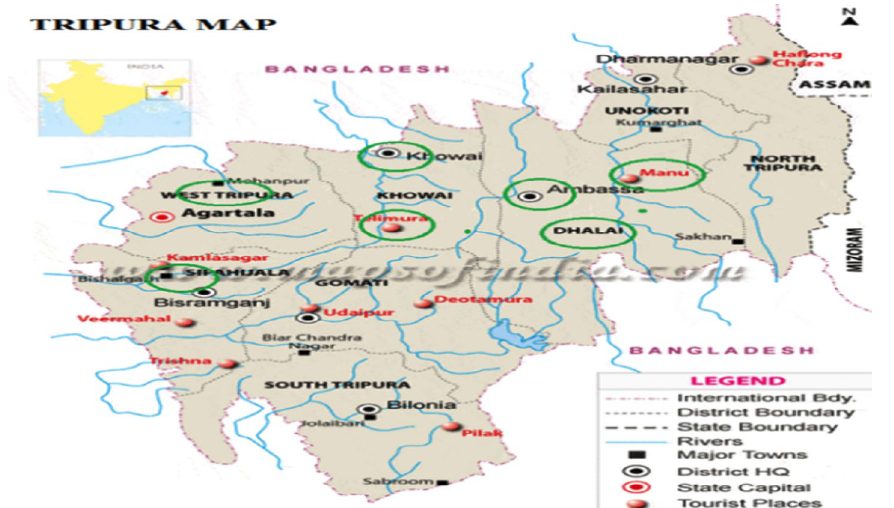
Fig. 1. Sample collection site (encircled with green colour) of Tripura, India.